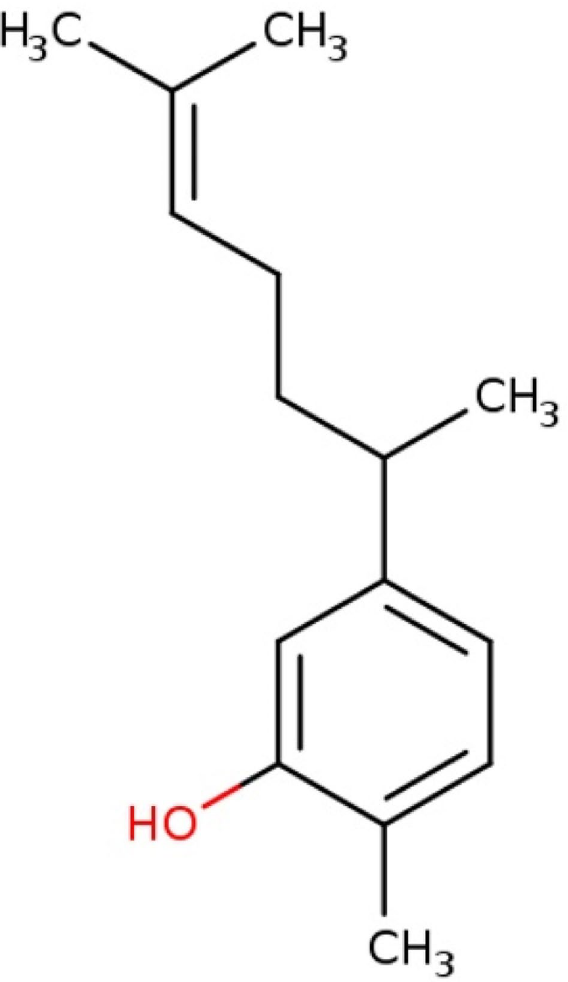
Figure 1. Structure of Xanthorrhizol (XNT).